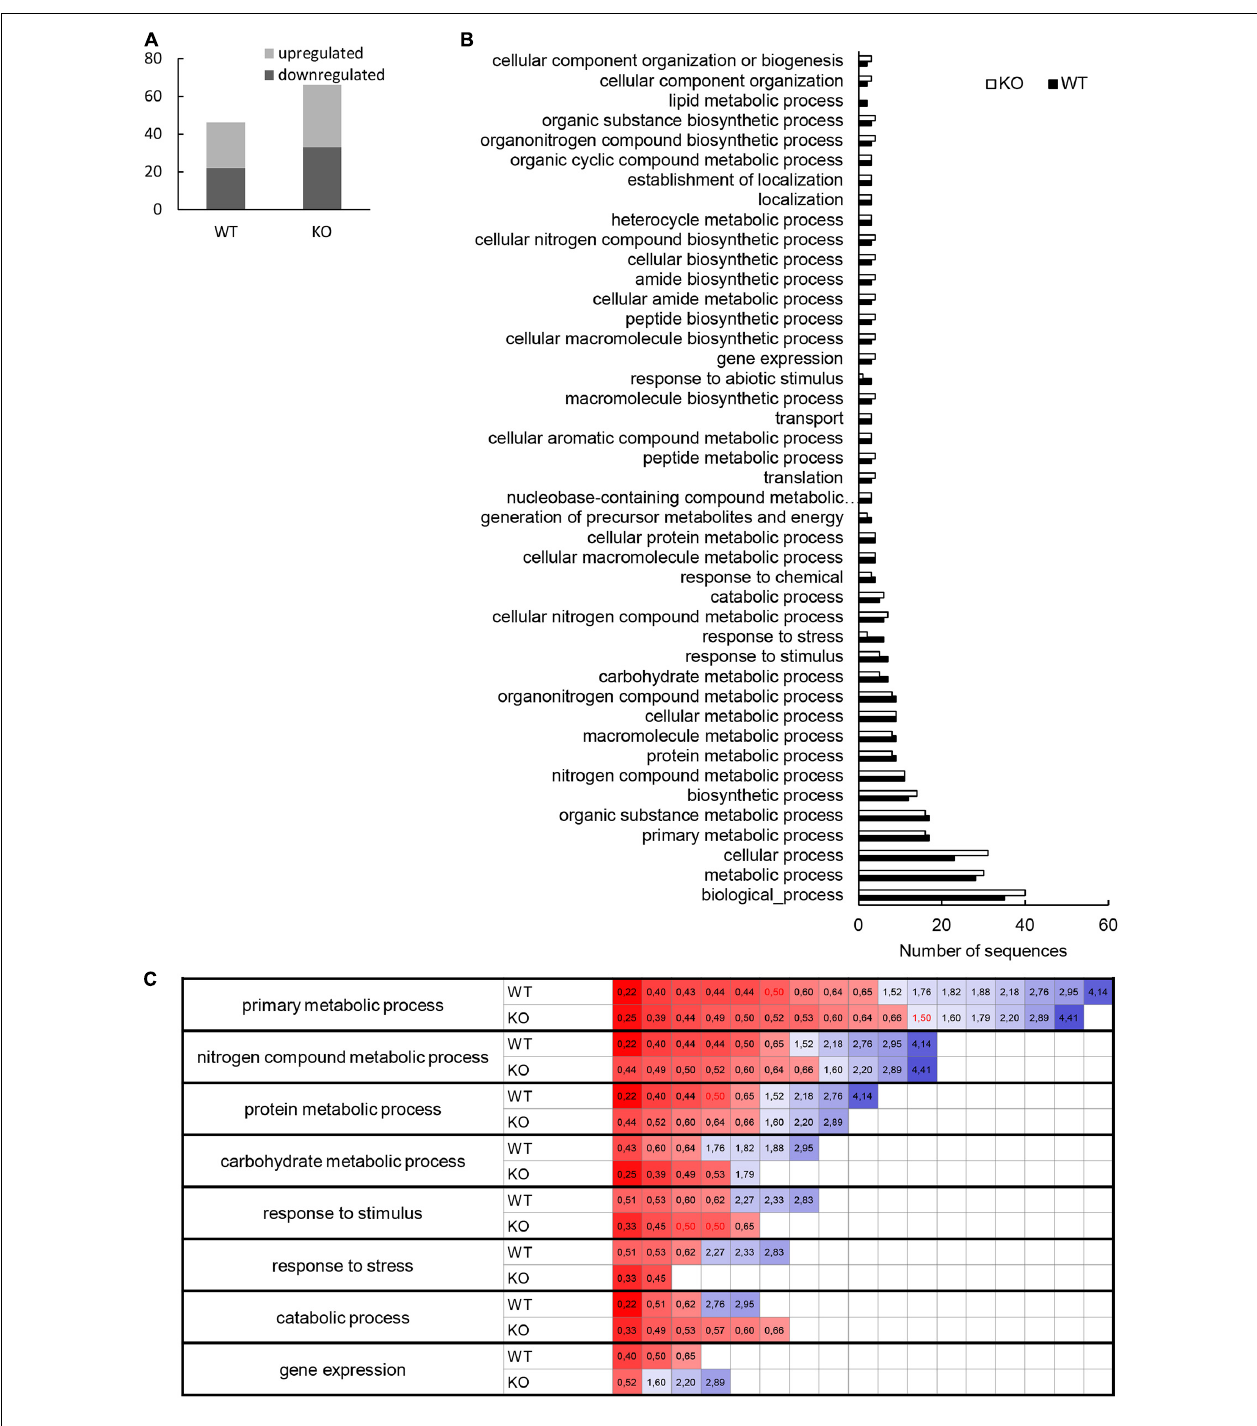
FIGURE 6 | Evaluation of differentially abundant root proteins found in wild type (WT) and HvMPK3 KO lines (KO) after flg22 treatment. (A) Graph showing numbers of down- and up-regulated proteins in the both lines as compared to control. (B) Graph showing a comparison of gene ontology annotation of differentially regulated proteins found in the analyzed lines. (C) Heat map showing the fold change of proteins annotated to the most important gene ontology annotations.